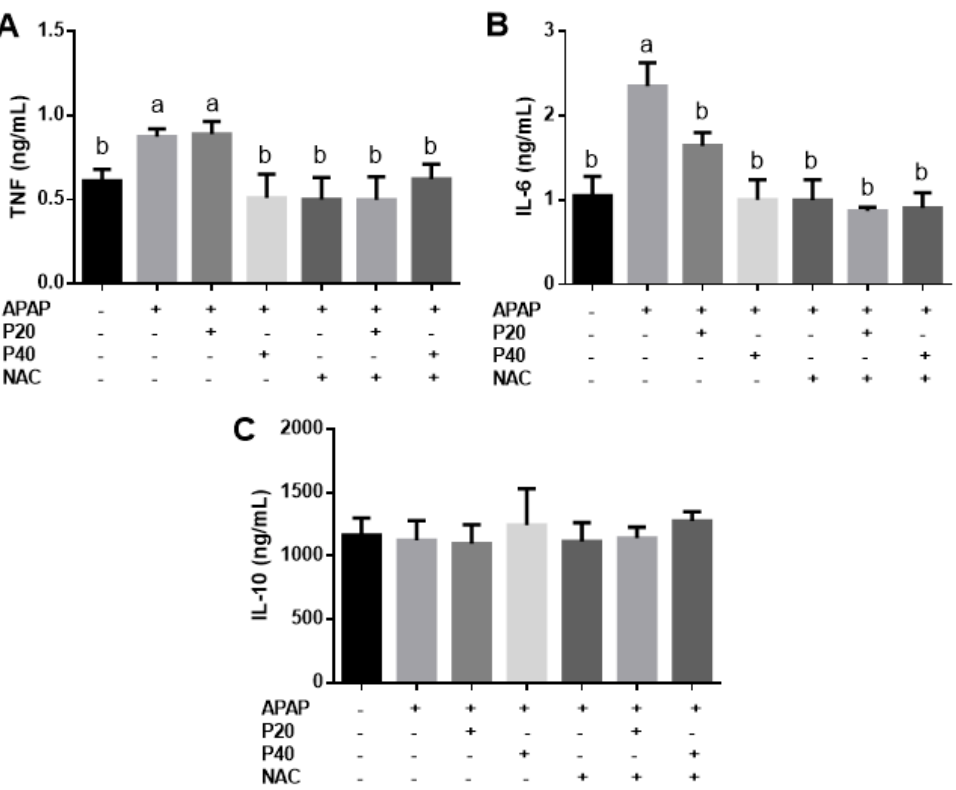
Figure 5. Evaluation of cytokines concentration in the serum: TNF ( A ); IL-6 ( B ); and IL-10 ( C ). Statistical analysis was performed using one-way analysis of variance and Tukey’s post-test. Different letters (a, b) indicate significant difference between groups ( p < 0.05), whereas the same letters indicate no significant difference between groups ( p > 0.05). (+) Presence or ( − ) absence of paracetamol, piperine 20 mg/kg, piperine 40 mg/kg, N-acetylcysteine. Abbreviation: TNF: tumor necrosis factor; IL-6: interleukin 6; IL-10: interleukin 10.